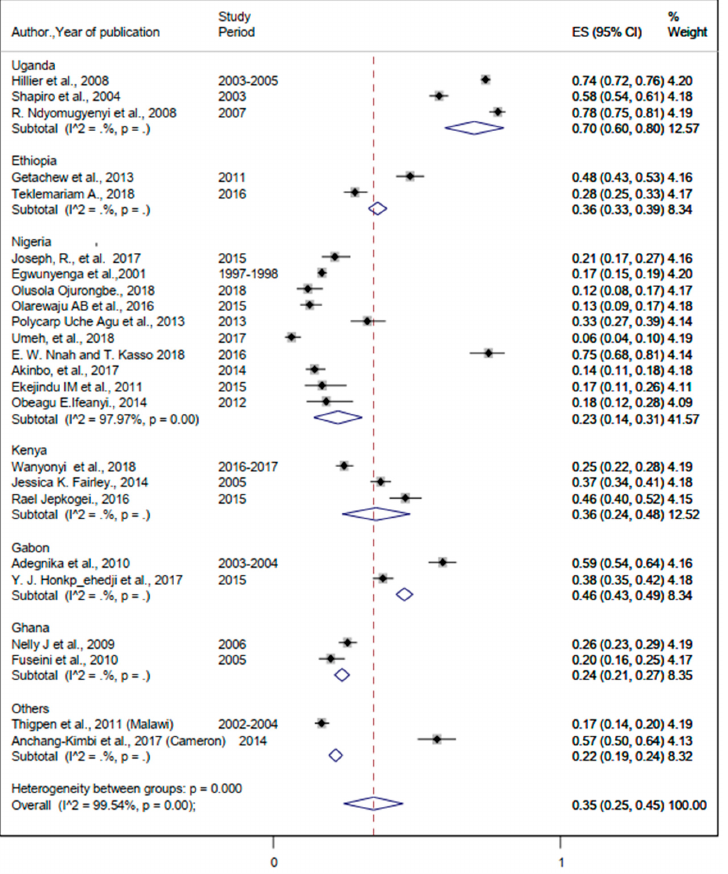
Figure 4. Forest plot for the overall and country-specific pooled prevalence of helminthic infection among pregnant women in sub-Saharan Africa.